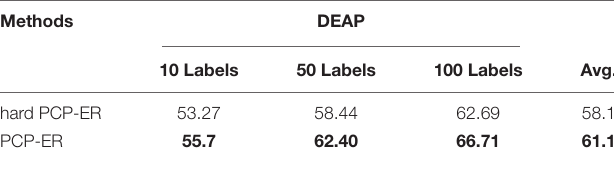
TABLE 6 | Performance comparison between hard PCP-ER and PCP-ER on DEAP